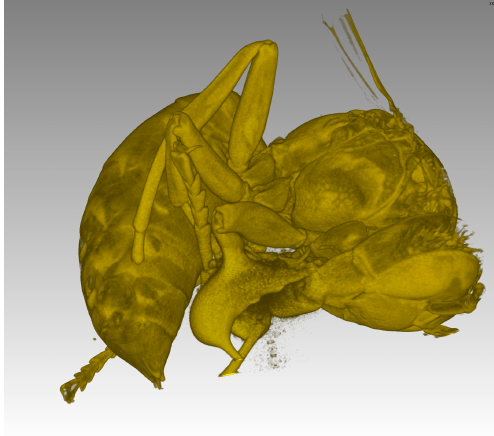
Figure 7. Neutron CT with 9 μ m voxel size.